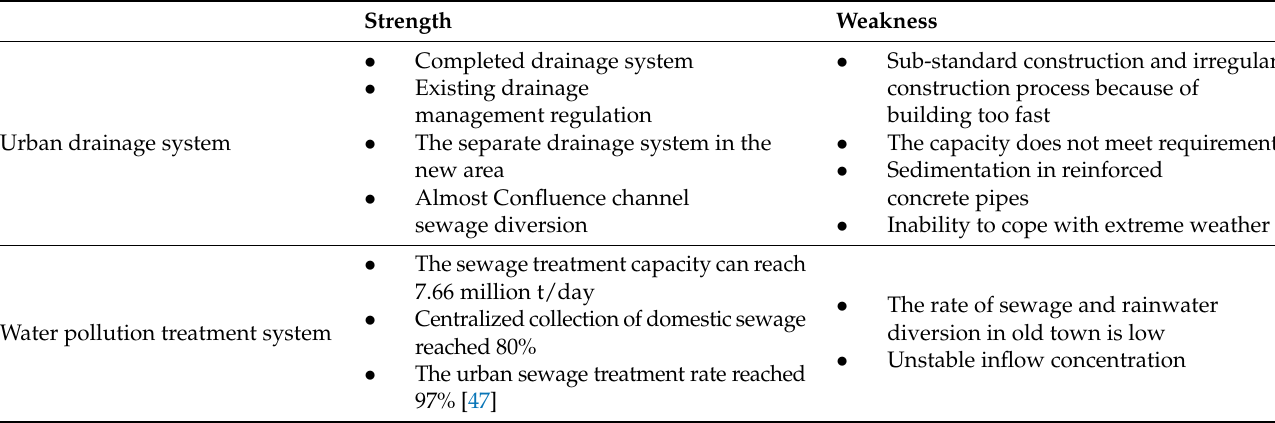
Table 2. SWOT analysis in